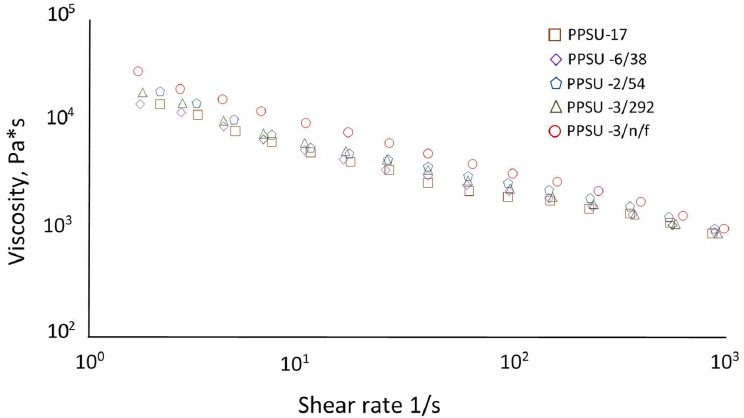
Figure 4. Flow curves of PPSU blends .